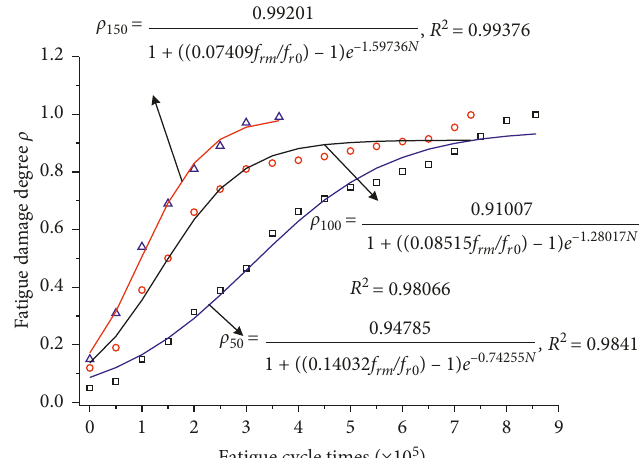
Figure 14: Fitting of damage variable curves of concrete specimens under different salt freezing cycles and fatigue